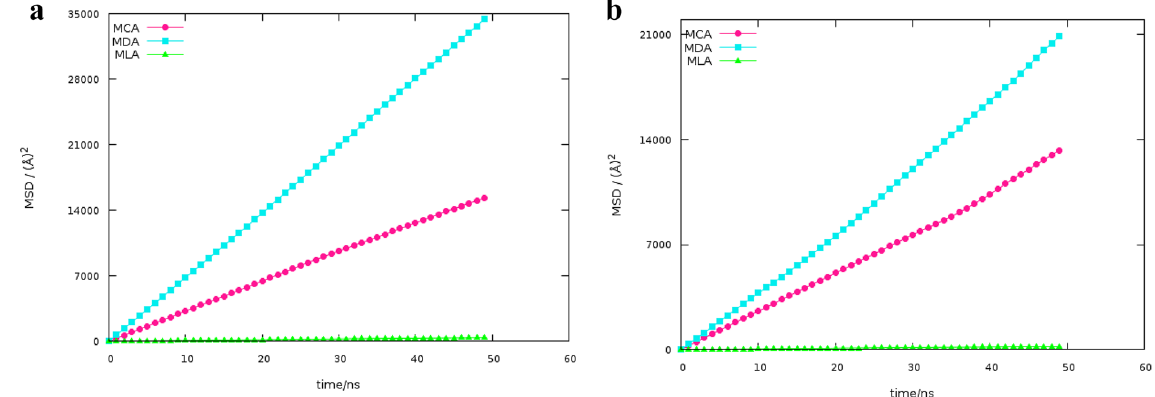
Figure 11. ( a ) The MSDs of the MEN for the binary mixtures of menthol and fatty acid with %FAs = 70 at 323 K, ( b ) The MSDs of the FAs for the binary mixtures of menthol and fatty acid with %FAs = 70 at 323 K.